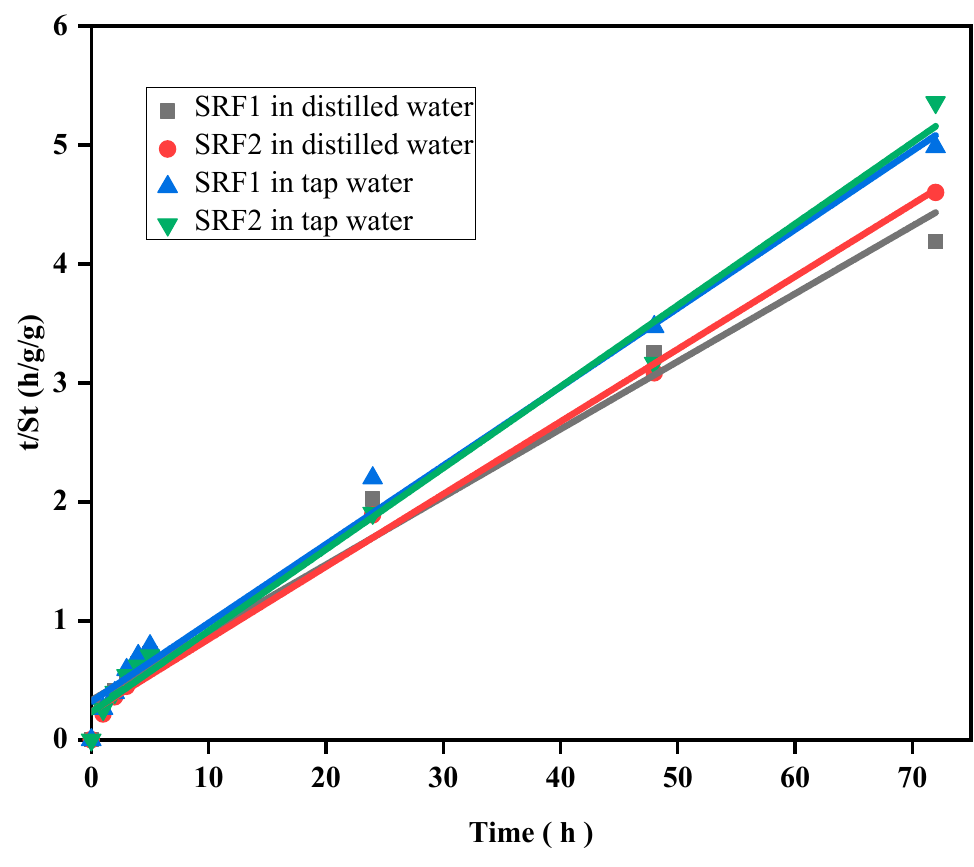
Figure 5. Swelling kinetics of hydrogel in solution. Table 1. Swelling kinetic parameters for the hydrogels in distilled and tap water. Conditions